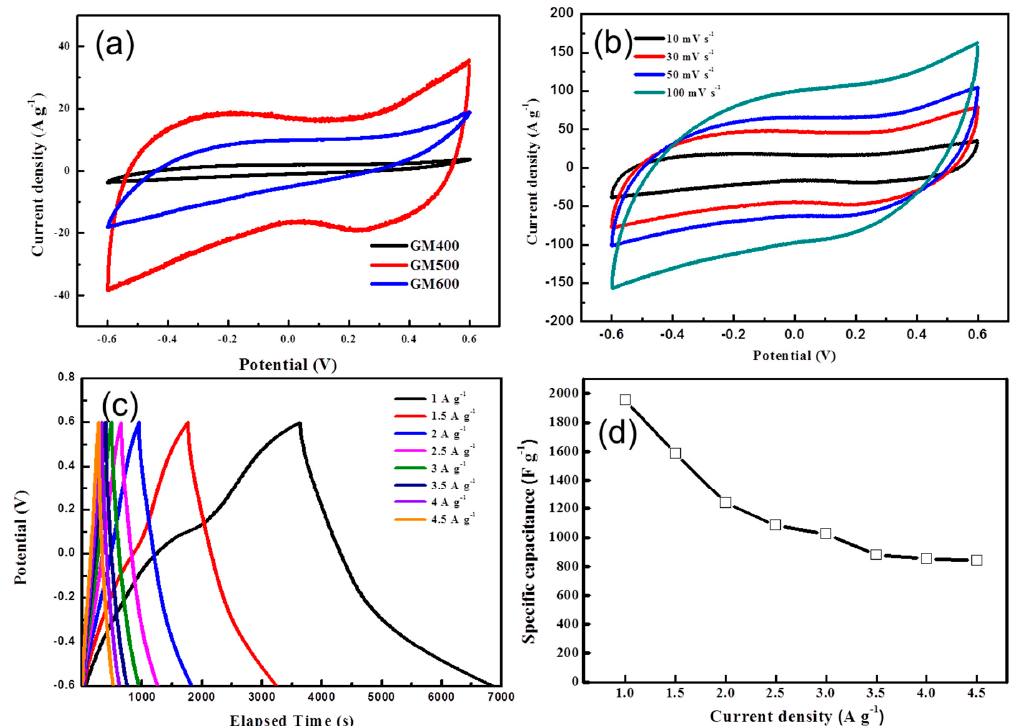
Figure 5. Cyclic voltammetry (CV) curves for ( a ) GM 400 , GM 500 , and GM 600 at a scan rate of 10 mVs − 1 , ( b ) CV curves of GM 500 at various scan rates, ( c ) Galvanostatic charge-discharge curves of GM 500 at different current densities, and ( d ) Specific capacitance vs. current density plot for GM 500 . The highest and lowest specific capacitance values were 1955.6 F g − 1 and 840.7 F g − 1 at current densities of 1 A g − 1 and 4.5 A g − 1 , respectively. These high capacitive performances might be due to